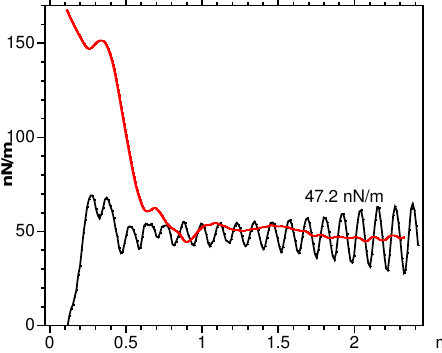
Figure 7. Electron density (a) and ion density (b) normalised to plasma-stream density in the final state ( t = 2 . 43ms) of run